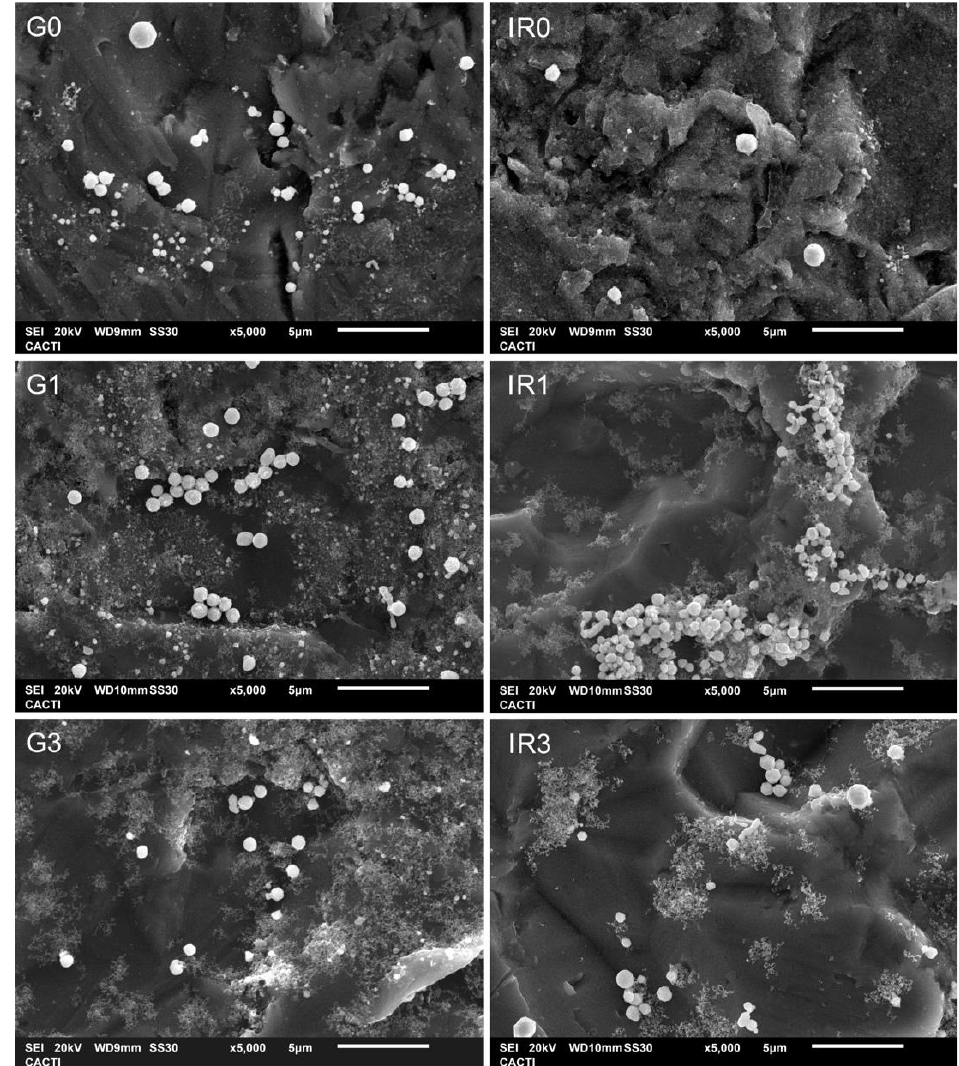
Figure 7. FESEM micrographs of titanium discs with immobilized Ag nanoparticles obtained in water: ( G0 ) by laser ablation with Green-nanosecond laser, ( IR0 ) by laser ablation with IR-picosecond laser, ( G1 ) after one re-irradiation with Green-nanosecond laser, ( IR1 ) after one re-irradiation with IR-picosecond laser, ( G3 ) after three re-irradiations with Green-nanosecond laser, and ( IR3 ) after three re-irradiations with IR-picosecond laser.